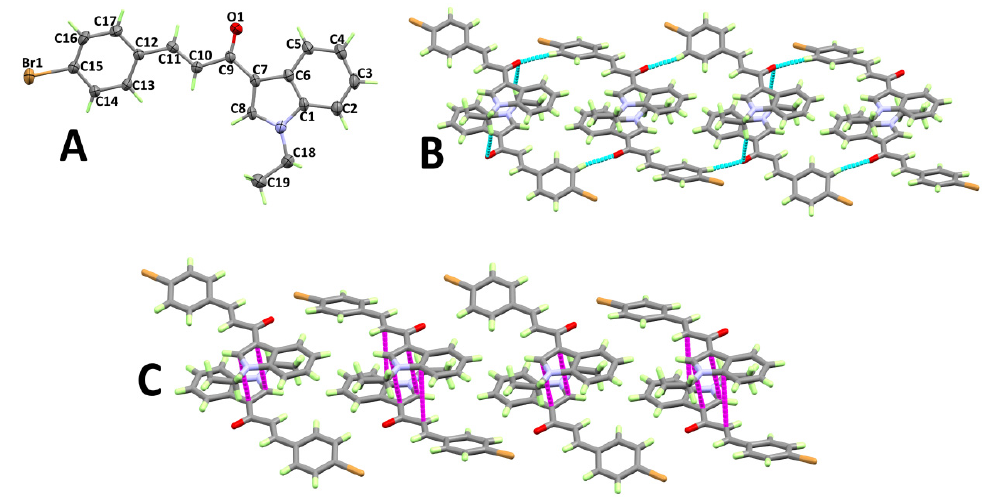
Figure 1. Atom numbering and thermal ellipsoids drawn at 30% probability level ( A ), hydrogen bonds ( B ), and π – π stacking interactions ( C ) in 3a. Table 1. Hydrogen bond parameters in the studied